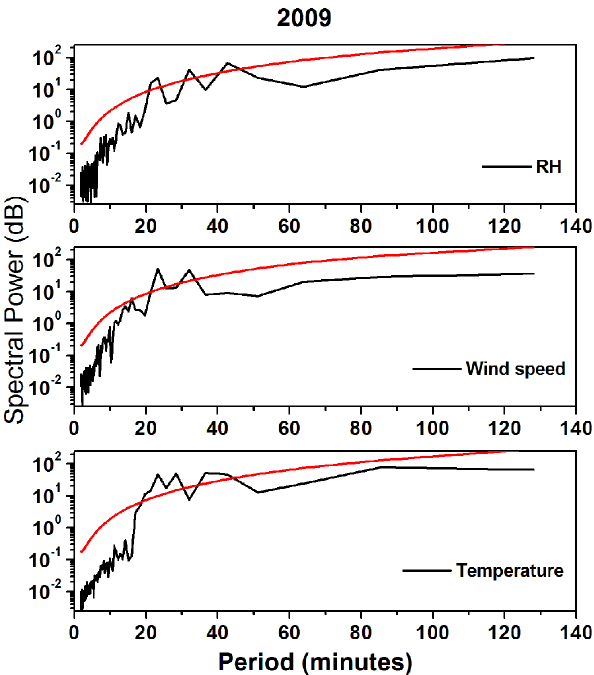
Fig. 7. Same as Fig. 5 but for all the experimental days in